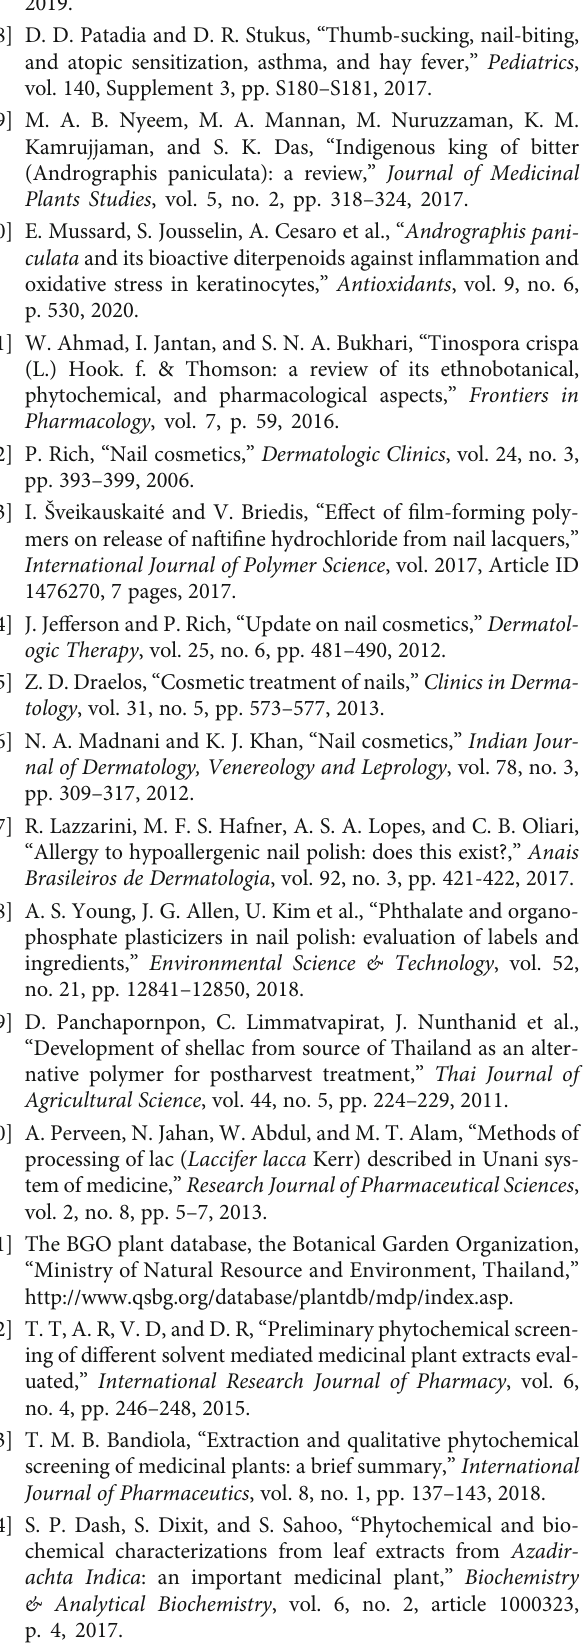
Figure S1: formulation No. 7A containing A. paniculata extract at 1% w / w (A), 10% w / w (B), and 20% w / w (C). Figure S2: formulation No. 19A containing T. crispa extract at 1% w / w (A), 10% w / w (B), and 20% w / w (C). Figure S3: sensory evaluation form ( Supplementary Materials